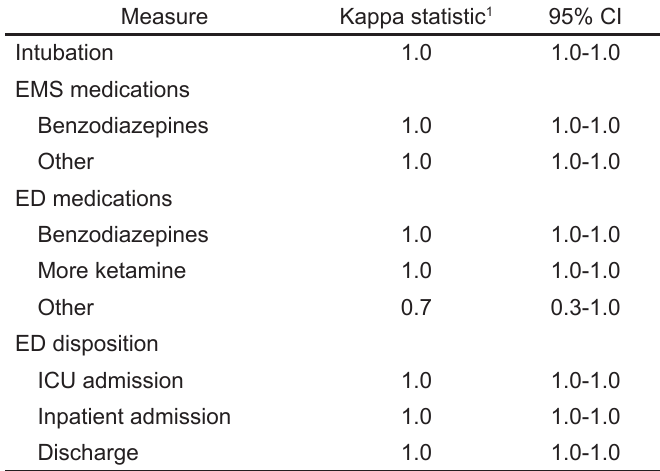
Table 3. Assessment of 20% sample for interrater agreement (N =